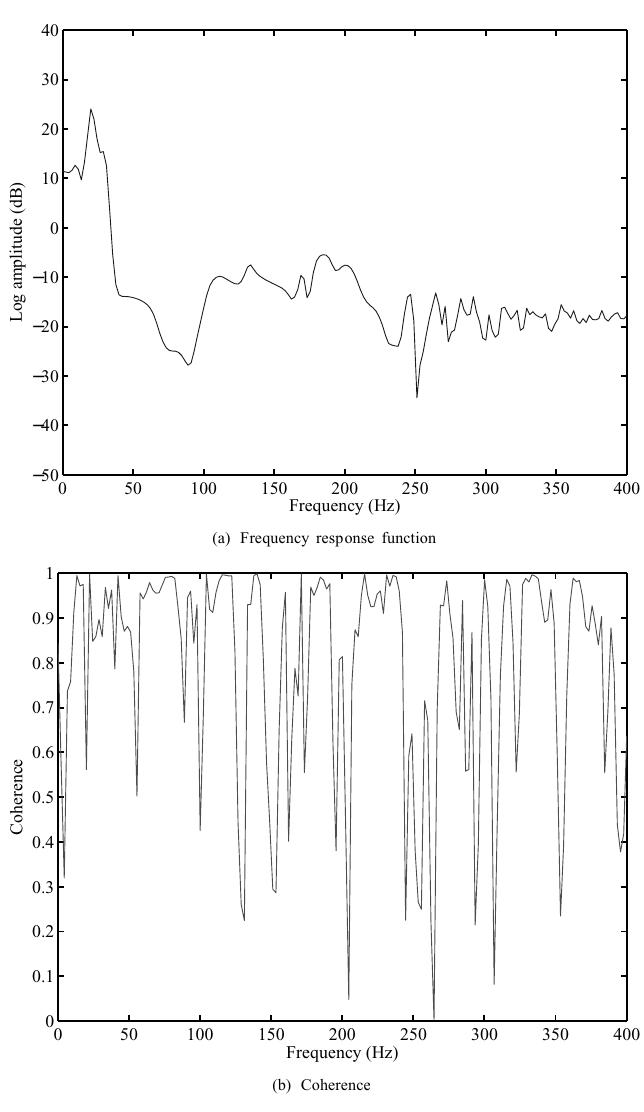
Fig. 9. Frequency response function and coherence between the input to the pile and the output of the pile